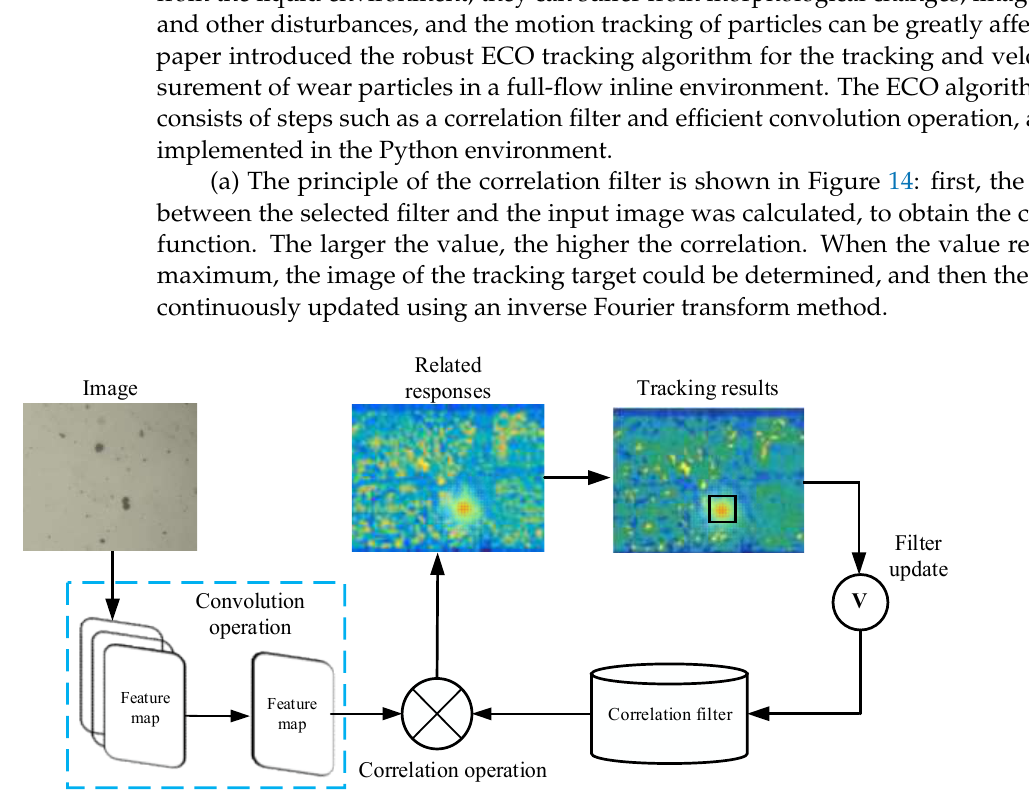
Figure 14. Schematic diagram of the tracking method based on a correlation filter. (b) For efficient convolution operation, the response function was obtained by first extracting the feature function of the input image using the resolution and combining it with the constantly updated filter. Then a matrix was created, to convolve the feature map based on the feature contribution, thereby reducing the dimensionality of the feature map.